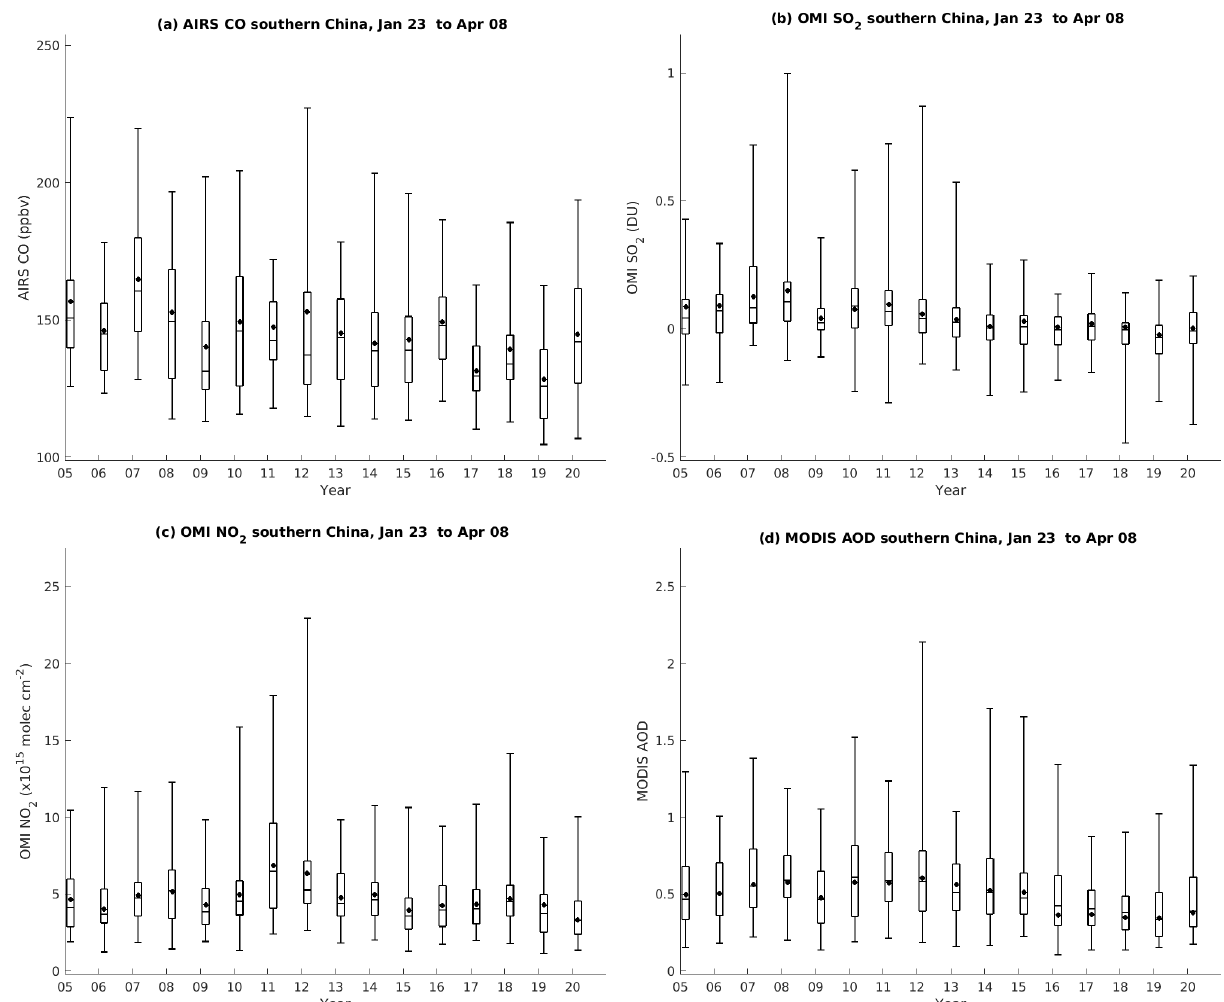
Figure 7. Same as Fig. 5 but for southern